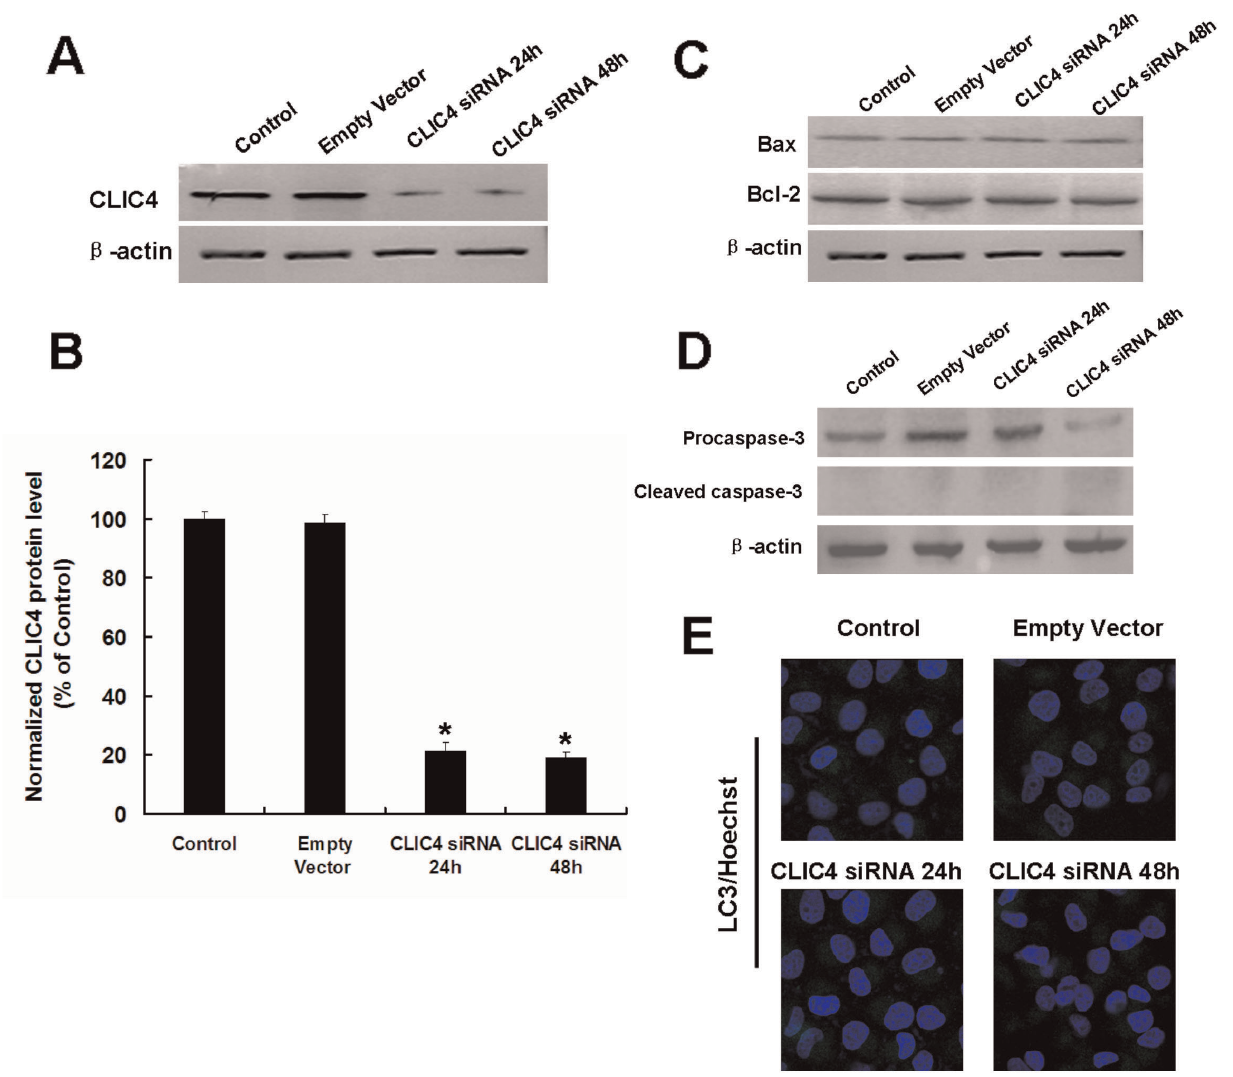
Figure 4. The effect of CLIC4 siRNA on apoptosis and autophagy in U251 cells. (A) Western blot analysis of CLIC4 expression in U251 cells transfected with a plasmid encoding empty vector or CLIC4 siRNA vector for 24 h and 48 h. (B) Densitometric analysis of CLIC4 levels. Data were presented as a mean 6 SD of three independent experiments. * P , 0.05 versus control group. (C) Western blot analysis of Bax and Bcl-2 expressions in U251 cells transfected with a plasmid encoding empty vector or CLIC4 siRNA vector for 24 h and 48 h. (D) Western blot analysis of Procaspase-3 and Cleaved caspase-3 expressions in U251 cells transfected with a plasmid encoding empty vector or CLIC4 siRNA vector for 24 h and 48 h. (E) LC3 immunostaining (Hoechst 33342 staining for the nucleus, 600 6 ) were observed by confocal microscopy in U251 cells transfected with a plasmid encoding empty vector or CLIC4 siRNA vector for 24 h and 48 h.